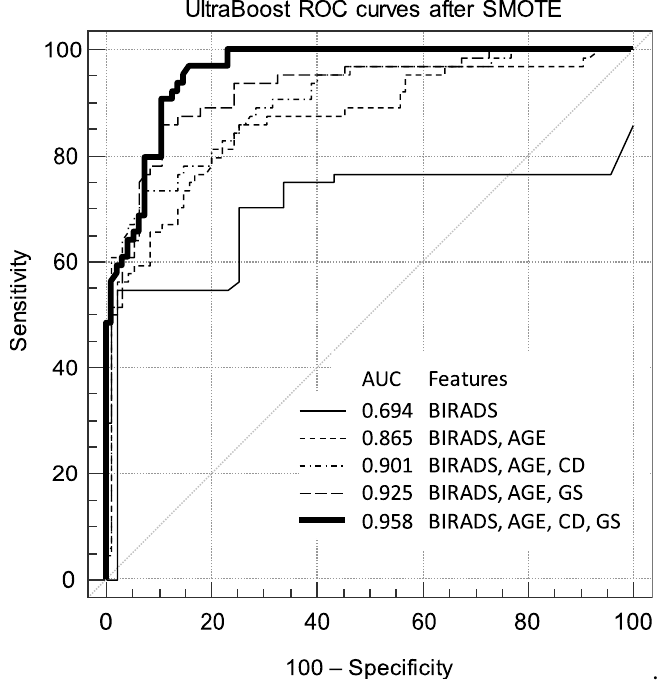
Figure 2. ROC curves for UltraBoost model with and without GS and CD features. Using CD features improves the diagnostic performance. Adding CD features to BI-RADS US and age increased performance from AUC = 0.865 ± 0.031 to 0.901 ± 0.025; adding CD features to the above and GS features increased the AUC from 0.925 ± 0.022 to 0.958 ± 0.013. (GS = grayscale; CD = color Doppler; AUC = area under the ROC curve; ROC = receiver operating characteristic; BI-RADS US = Breast Imaging Data and Reporting System for ultrasound).